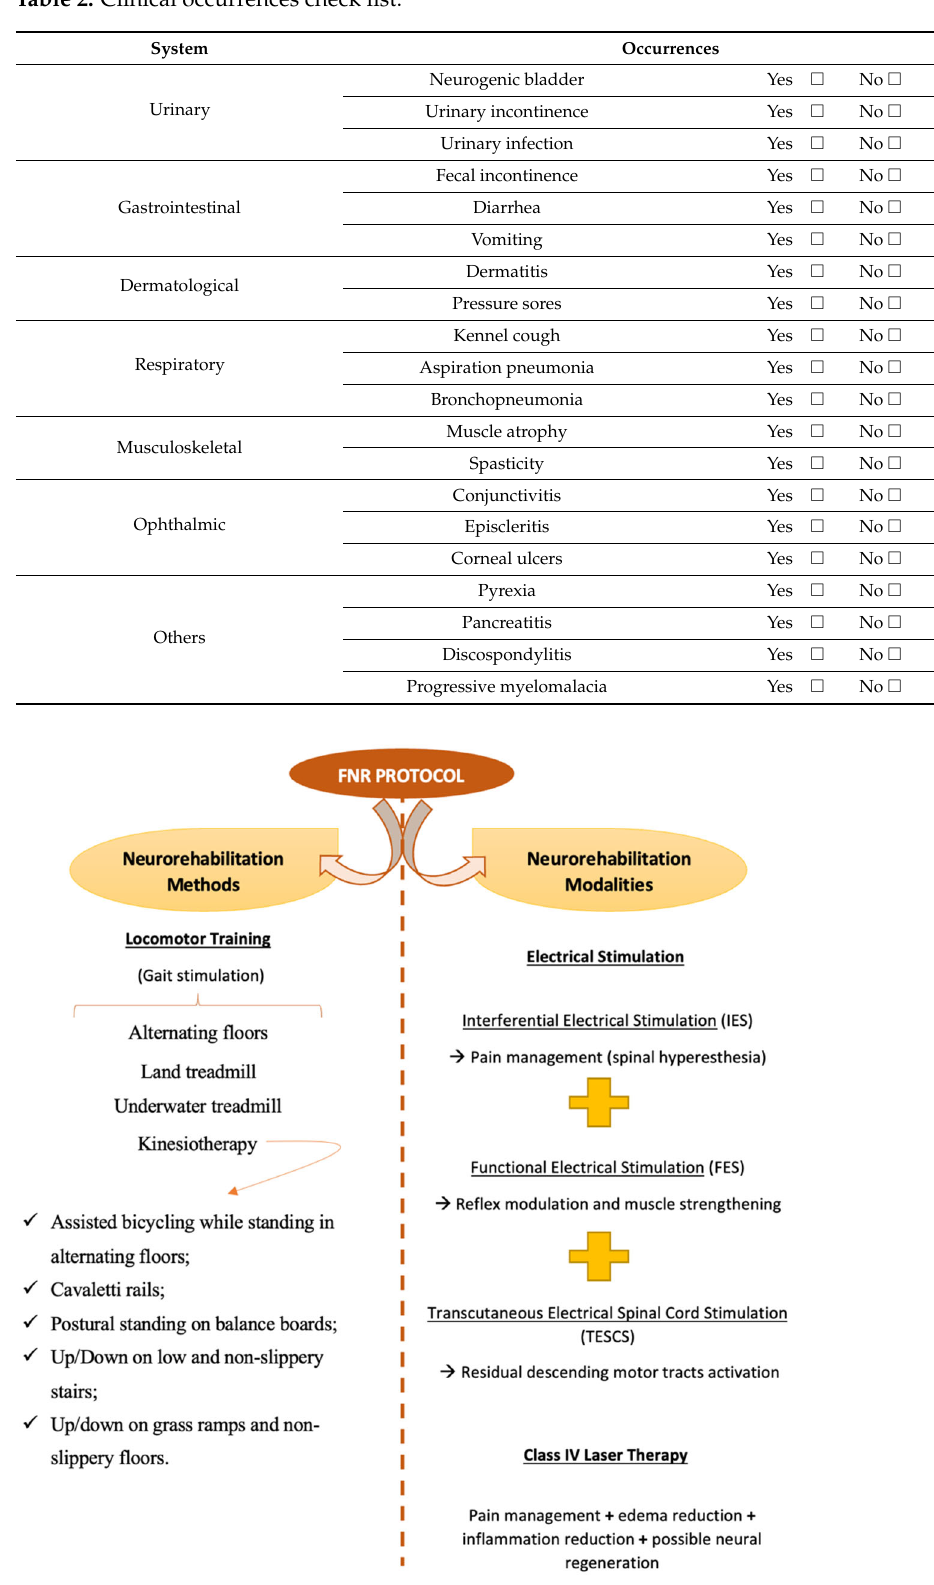
Figure 1. Overall FNR protocol prescribed for the study population ( n =